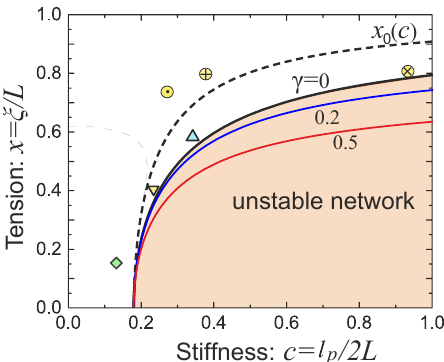
Figure 10. The map of network stability, in parameters of filament stiffness c , and and the filament pre-tension x , showing the boundary of network stability at several values of applied shear γ